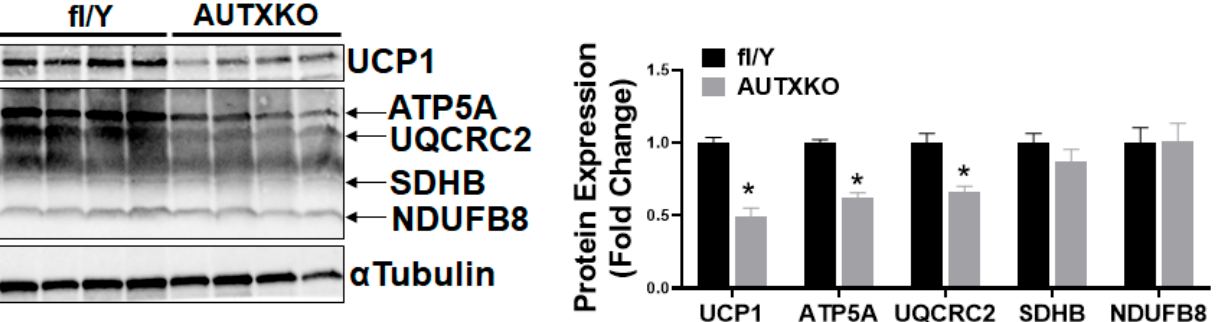
Figure 2. Utx deficiency impairs brown fat thermogenic program in mice fed a chow diet. Three-week-old male AUTXKO and fl/Y animals were maintained on a regular chow diet throughout the experiment. UCP1 protein and mitochondrial respiratory chain complex protein in iBAT were assessed by western blot. Left: representative blot images; right: densi- tometry quantitation. All data are presented as mean ± S.E.M.; n = 4/group; * p < 0.05 vs. fl/Y .